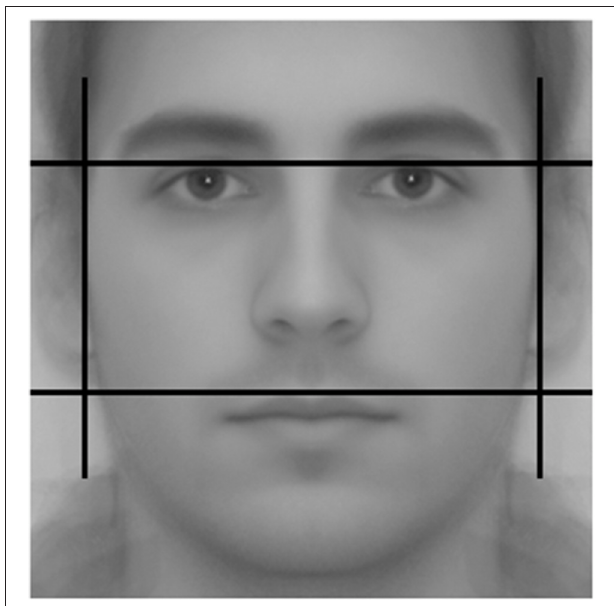
FIGURE 1 | Facial measures used to compute